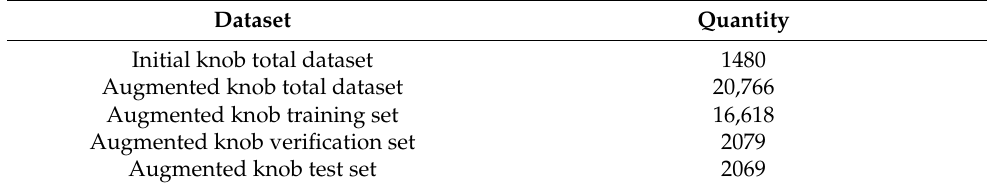
Table 2. Knob experiment